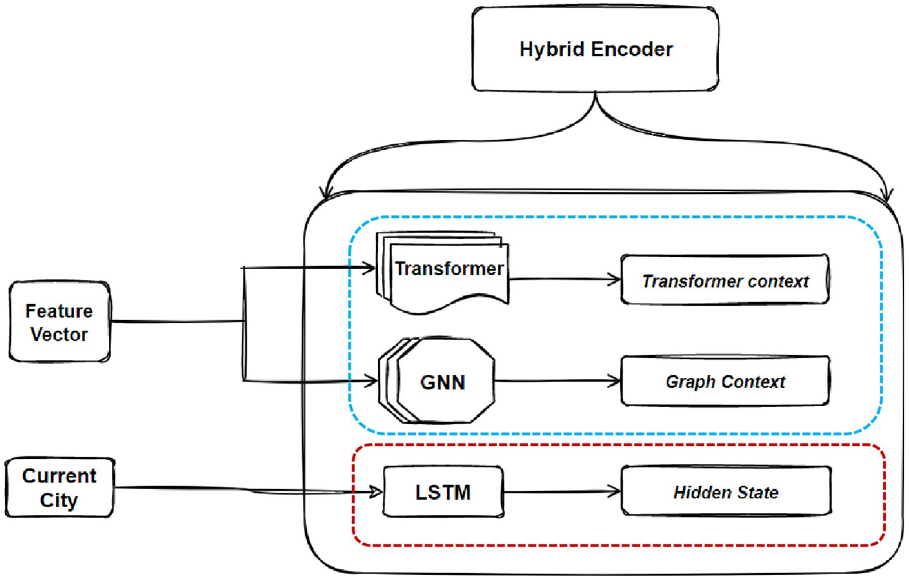
Fig 2. Hybrid encoder consists of transformer’s encoder and graph embedding layer as a hybrid context encoder, (blue dotted box) for the hybrid context encoder and (red dotted box) for the point encoder.